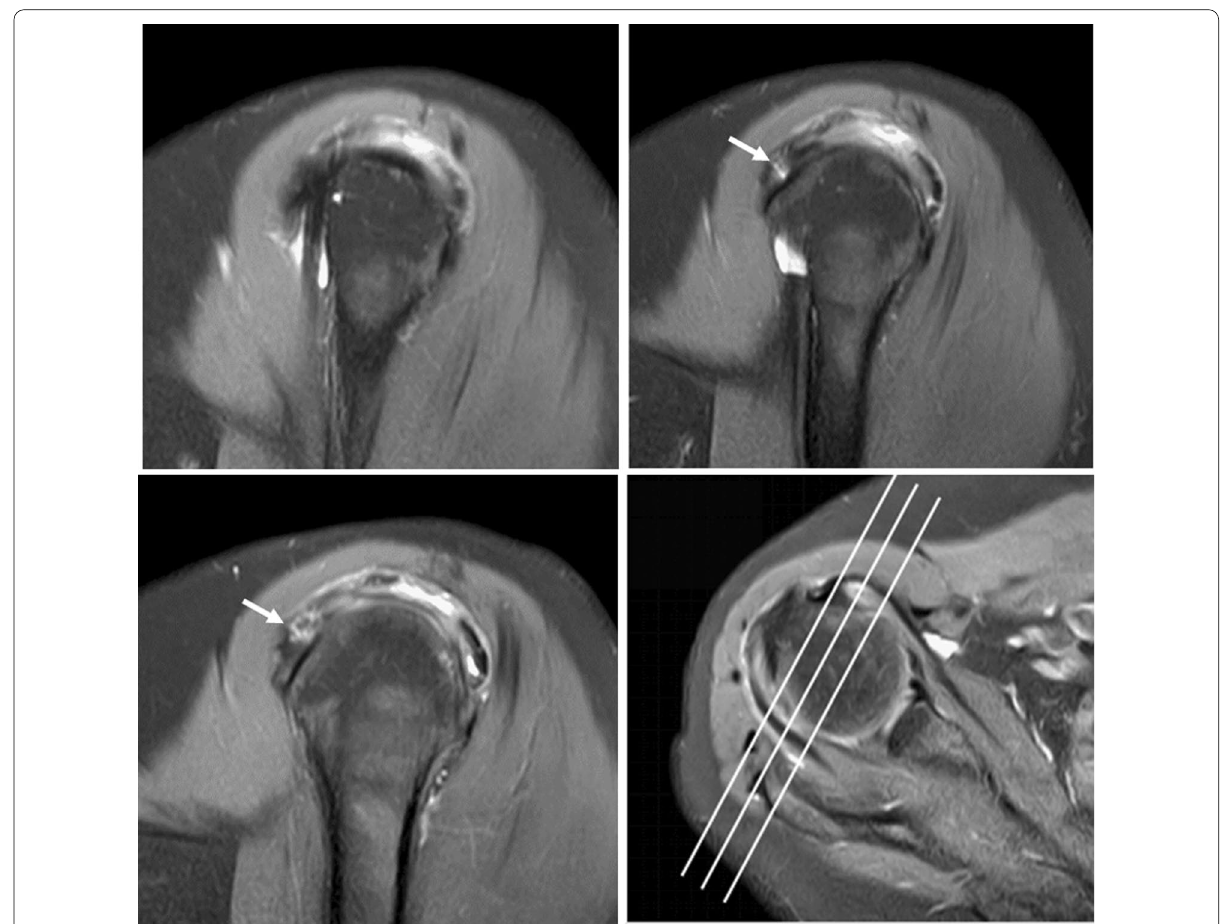
Fig. 2 Type-B of fissure sign. There is a vertical fluid-filled gap into the tendon involving both sides surface of SSC at the continuous two slices on oblique sagittal IM-WI/fs MRI counted from the most lateral cortex of lesser tuberosity to the medial SSC footprint area referring to the axial MR image (white